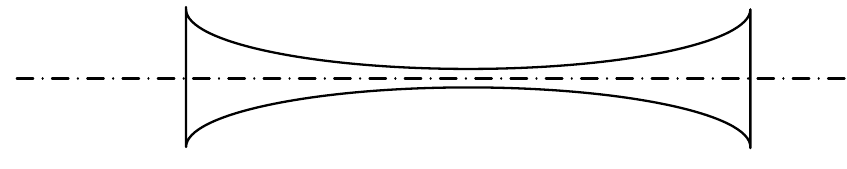
Fig. 10. Shape of a rod producing vibration confinement at the middle